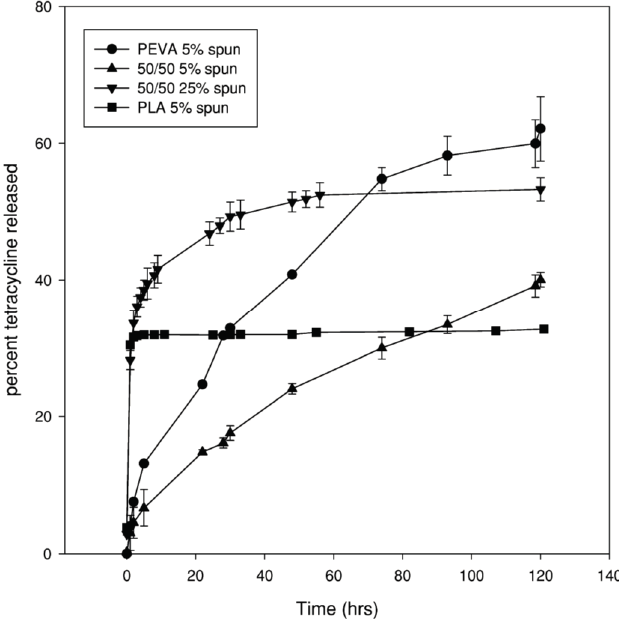
Figure 8. Percentage release rate of tetracycline HCL loaded nanofibrous mats versus time (h). Reprinted with permission from [17], Copyright © 2002 Elsevier Science B.V.